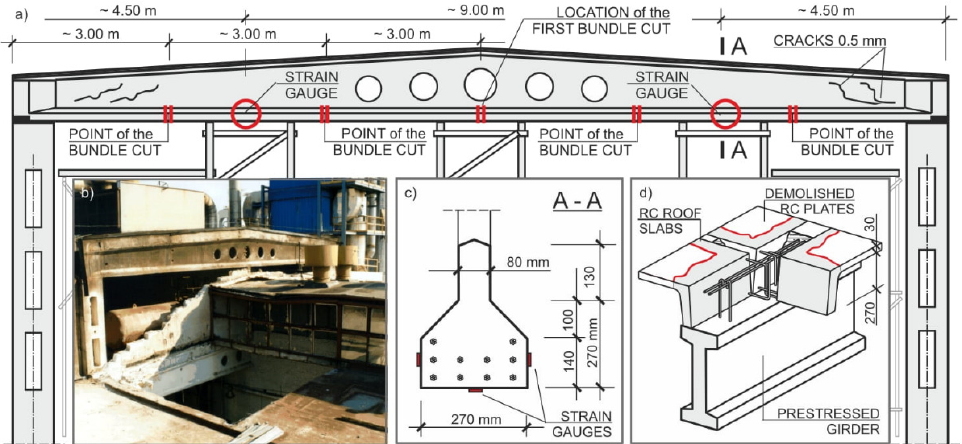
Figure 7. Production hall of wooden chipboards: ( a ) cross section; ( b ) degradation after explosion; ( c ) strain gauges’ locations, ( d ) RC plate demolition.